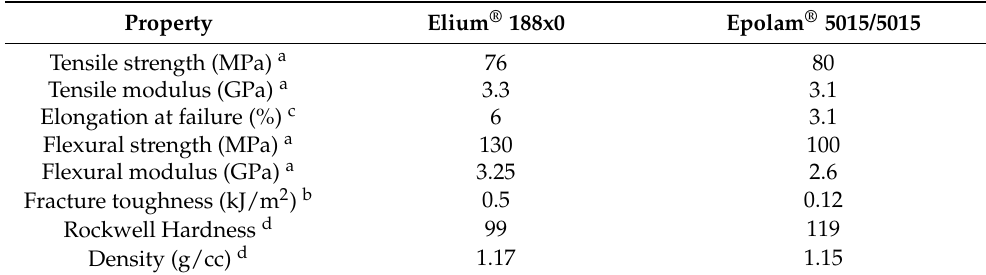
Table 1. Summary of mechanical properties of the thermoplastic matrix (Elium ® 188x0) and thermoset matrix (Epolam ® 5015).